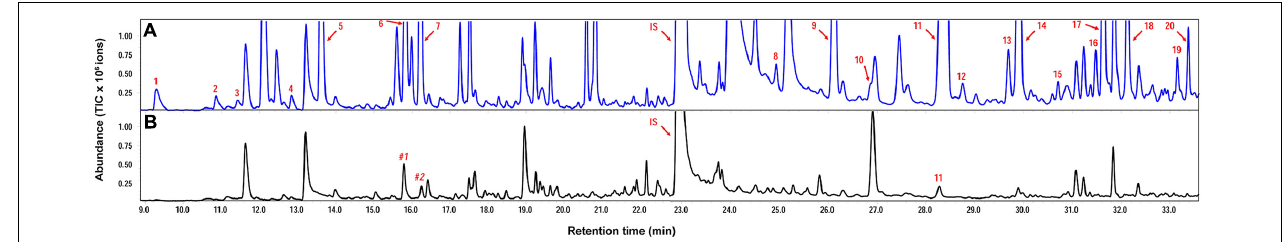
FIGURE 6 | Representative chromatograms of volatile terpenes from Gossypium barbadense infested by Helicoverpa armigera (A) and from undamaged control plants (B) . Numbered compounds correspond to those in Table 1 . IS, internal standard (ethyl nonanoate); #1, Non-anal; #2, 1,2,4,5-tetramethylbenzene.